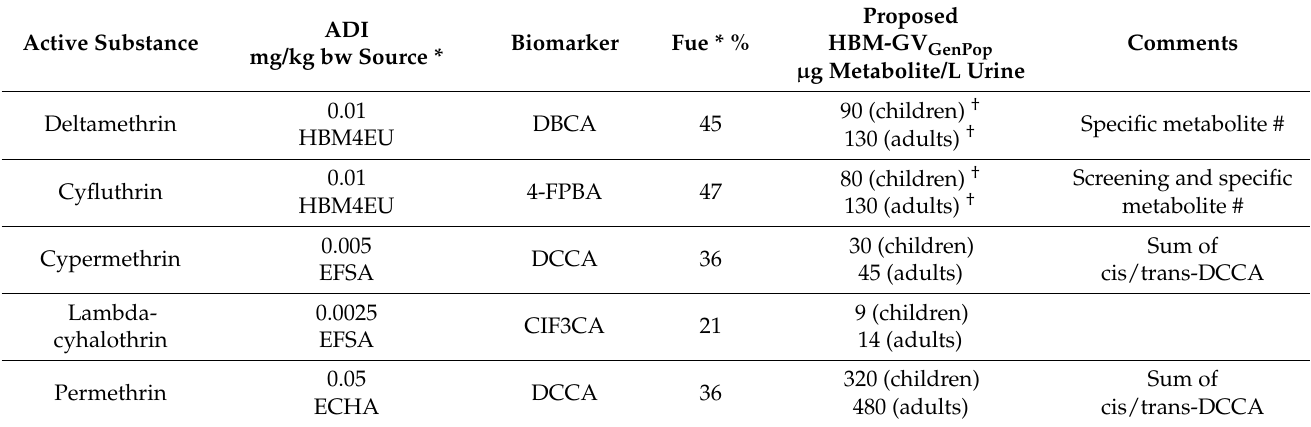
Table 3. Biomarkers for pyrethroid exposure, HBM-GVs, and their